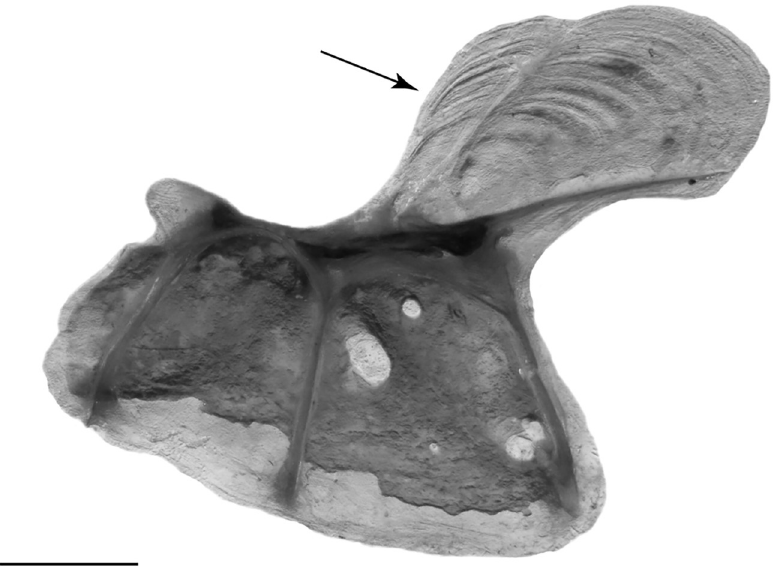
Fig 2. Infraorbital 1+2 of Eigenmannia sirius , MZUSP 118582, 93.3 mm L EA , paratype. Arrow indicates the posterodorsal expansion. Scale bar = 1